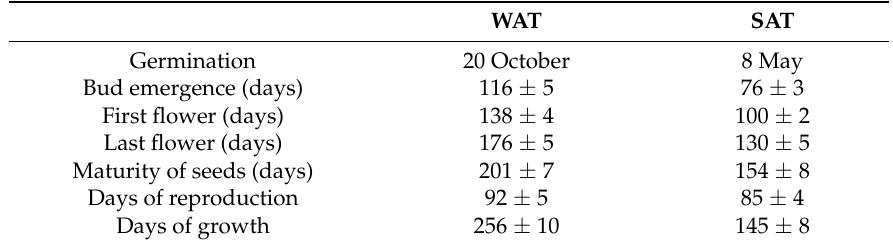
Table 3. Effect of planting date on genotypes across three years for the mean of all agronomic traits